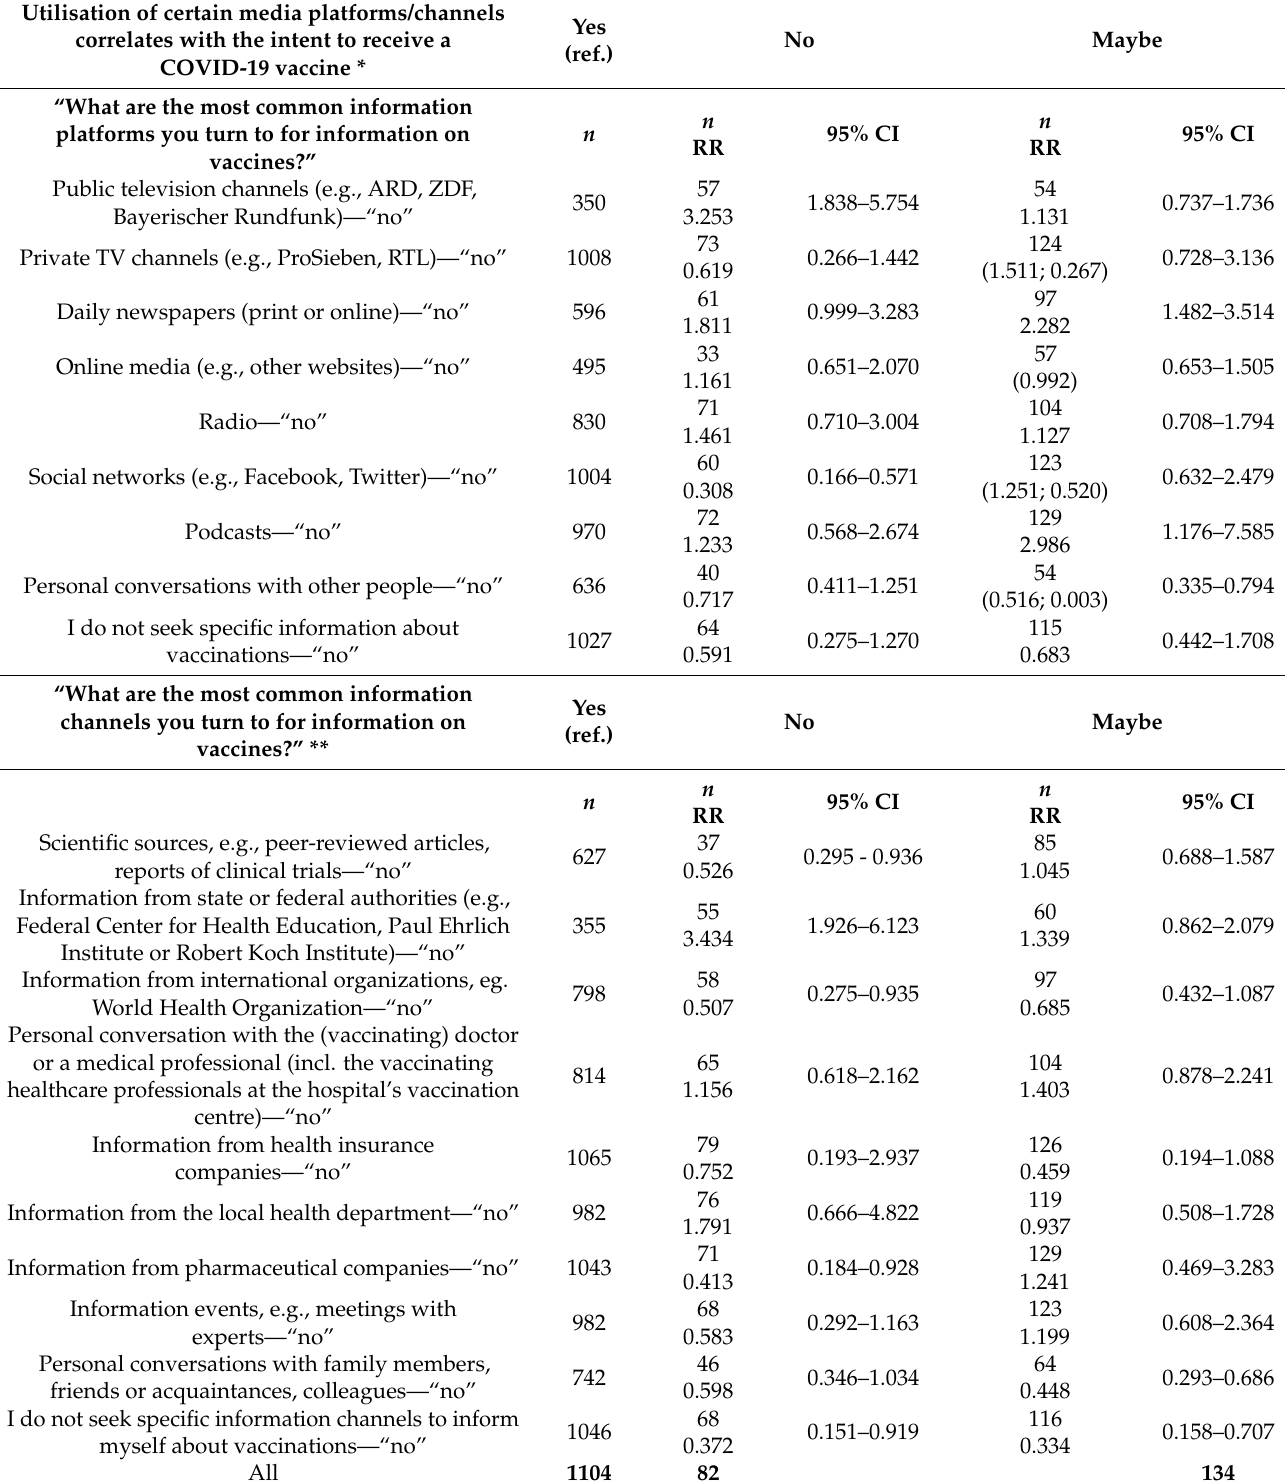
Table 10. Multinomial logistic regression models for the utilization of certain media plat- forms/channels associated with the intent to receive a COVID-19